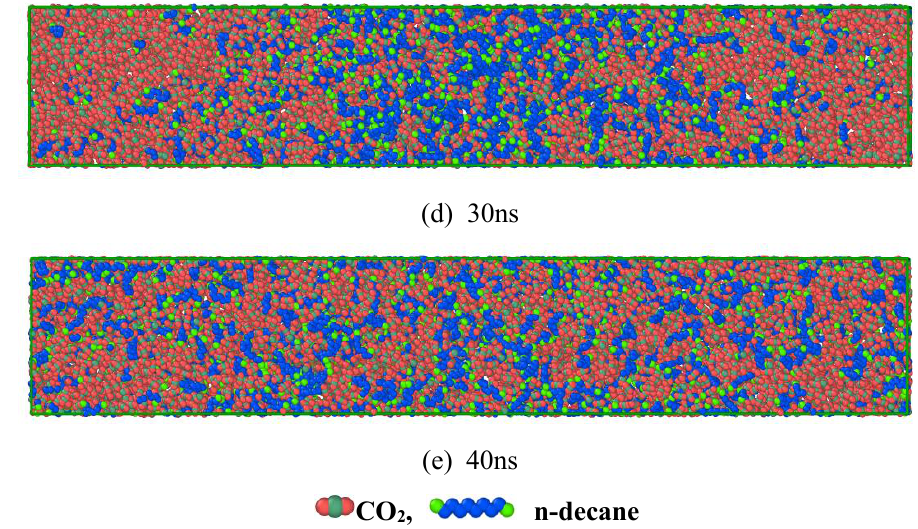
Figure 3 — CO 2 /n-decane mixed-phase microscopic processes.